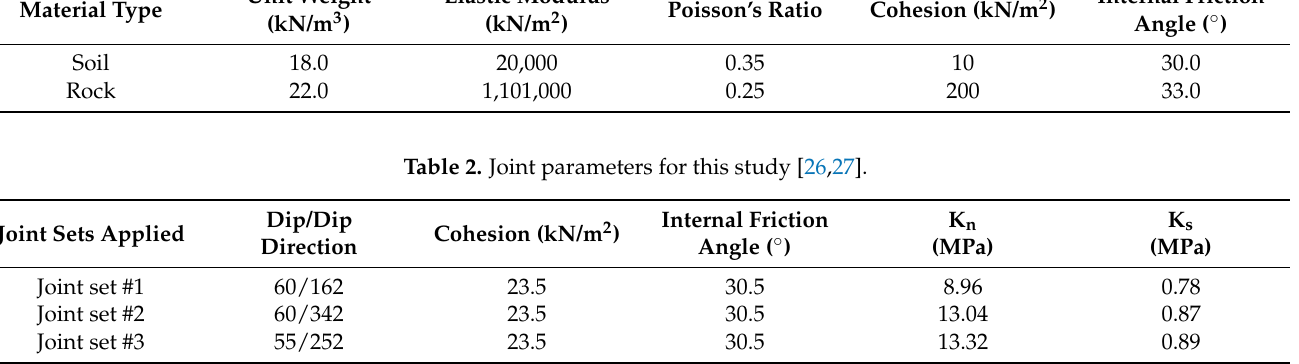
Table 2. Joint parameters for this study [26,27].